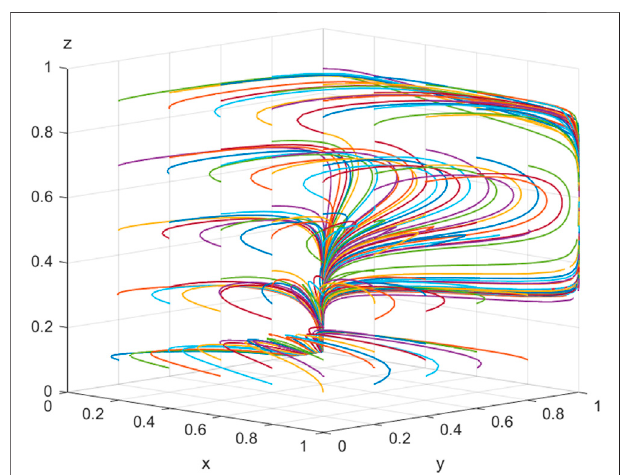
FIGURE 15 | Fifty evolution results of array